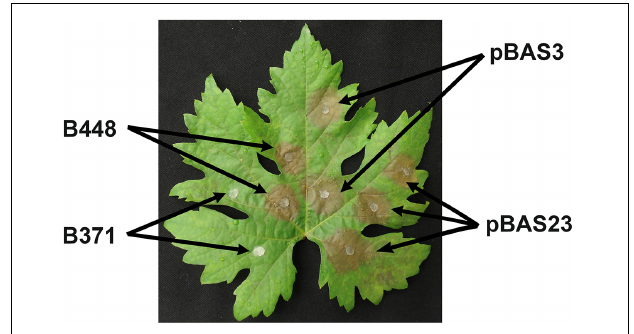
FIGURE 4 | Pathogenicity in V. vinifera leaves of transformants obtained with plasmids pBAS3 and pBAS23 in comparison with isolates B448 and B371. Non-wounded leaves were inoculated with the indicated isolates and incubated at 22 ◦ C under a 16 h photoperiod. Image was taken 72 h after